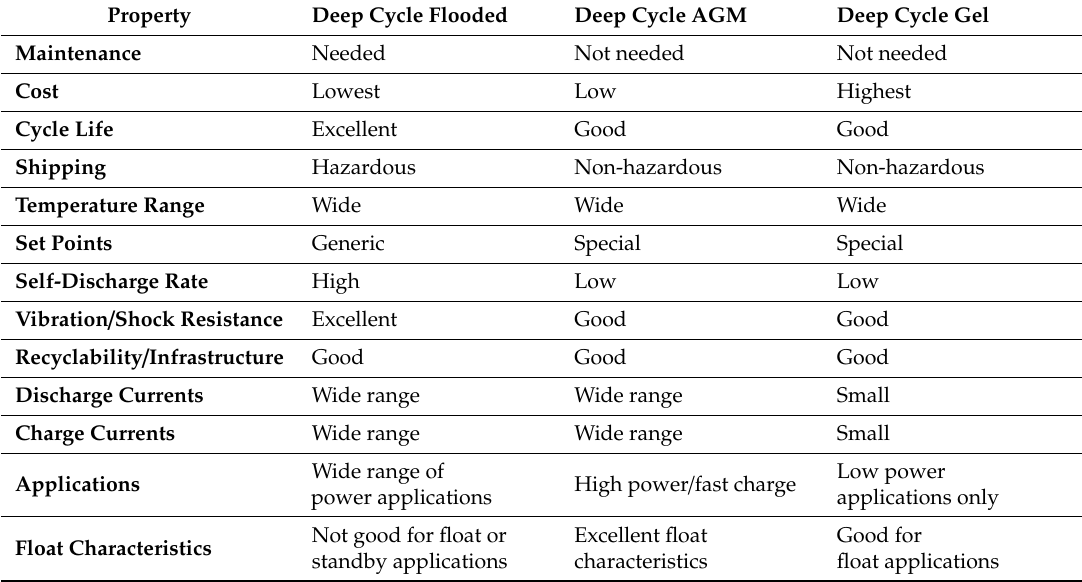
Table7. Acomparativepictureofdeep-cycleflooded,